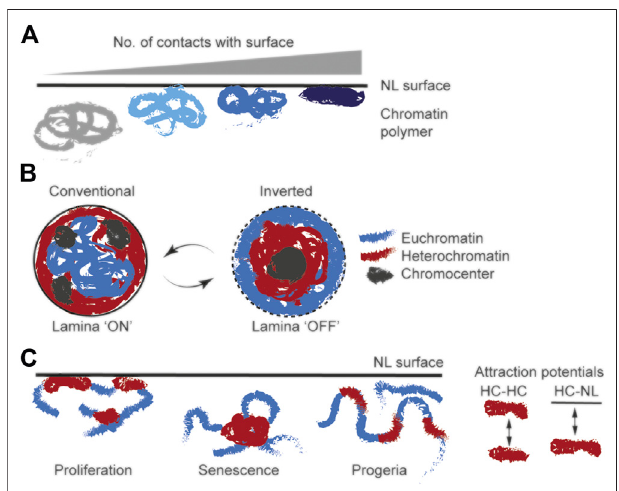
FIGURE 4 | Chromatin con fi gurations at a NL predicted from polymer models near a hard surface (A) Conformation of a chromatin polymer fi tted with an increasing number of contact points with a NL surface in simulations (Ulianov et al., 2019): increasing the number of contacts decreases LAD volume and ultimately results in a “ pancake ” con fi guration at the surface (B) Nucleus-wide radial arrangement of heterochromatin and euchromatin compartments in models of conventional and inverted nuclei; turning off a NL attraction potential (lamina OFF) results in the inverted con fi guration with euchromatin at the nuclear periphery (Falk et al., 2019) (C) Chromatin con fi guration at a NL surface after modeling cells in proliferating, senescence and progeroid states; variations in con fi gurations result from tuning attraction potentials between heterochromatin (HC) blocks and between heterochromatin (HC) and NL (Chiang et al., 2019; Sati et al.,